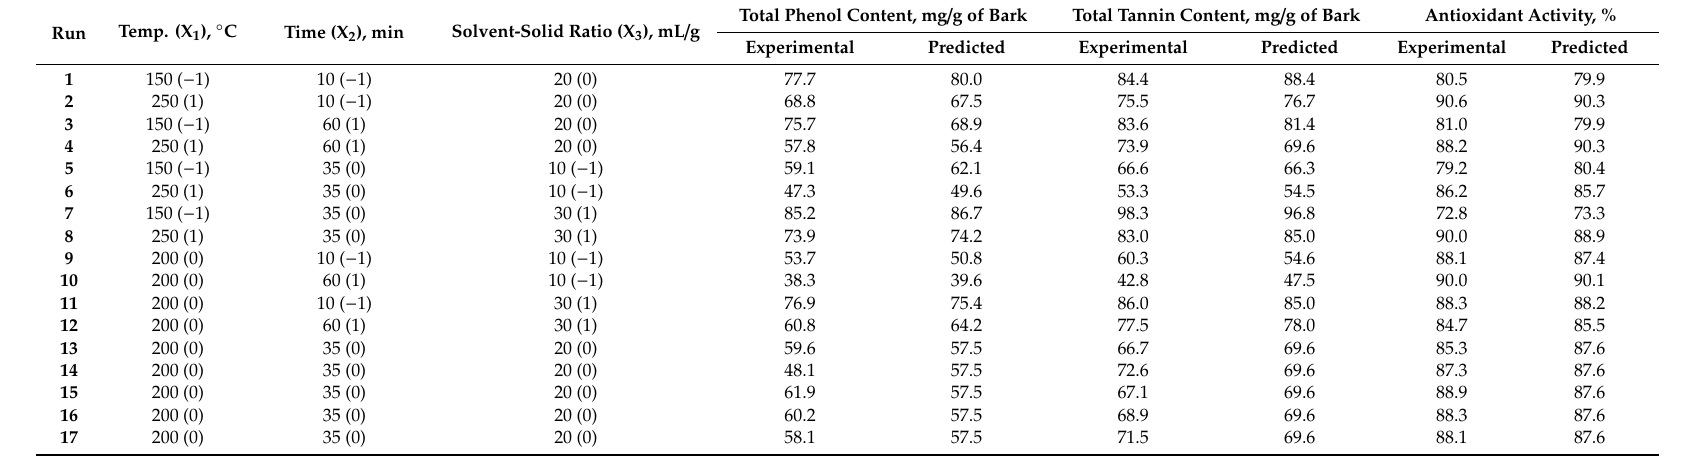
Table 3. Proposed experiments by the Box–Behnken method and the predicted and experimental values of total phenol content, total tannin content and antioxidant activity of extracts obtained by subcritical water extraction of chestnut